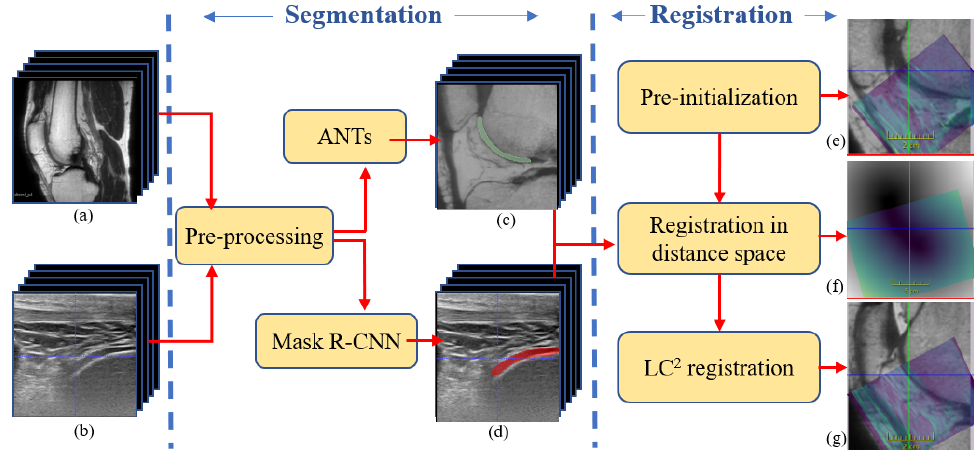
Figure 2. Flowchart of the proposed algorithm. ( a , b ) input MRI and US volumes; ( c ) segmented femoral cartilage from MRI using the atlas based deformable registration performed by ANTs (Advanced Normalization Tools); ( d ) segmented femoral cartilage from US using the Mask R-CNN framework; ( e – g ) registration output after each stage of the algorithm (US slice shown in blue, overlaid on a respective MRI